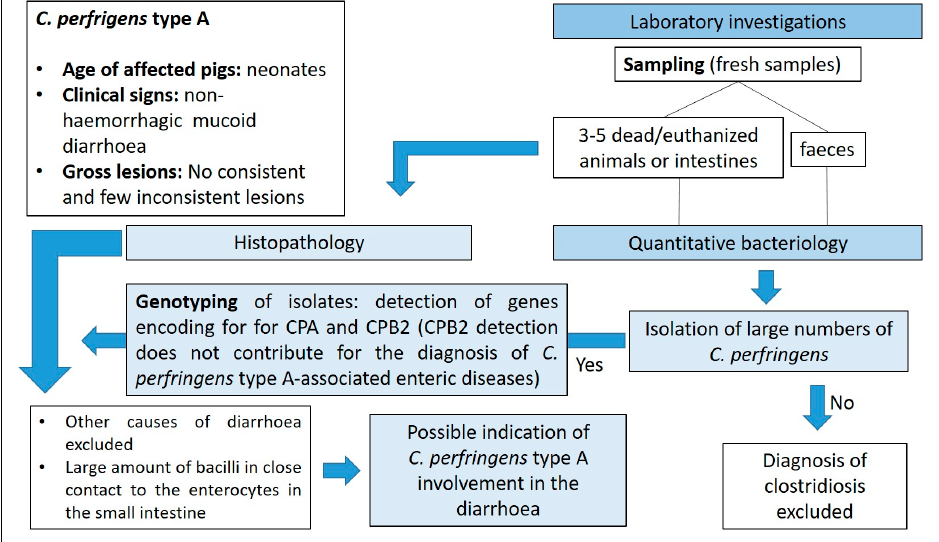
Figure 12. Diagnostic algorithm for the diagnosis of clostridiosis due to C. perfringens type A in